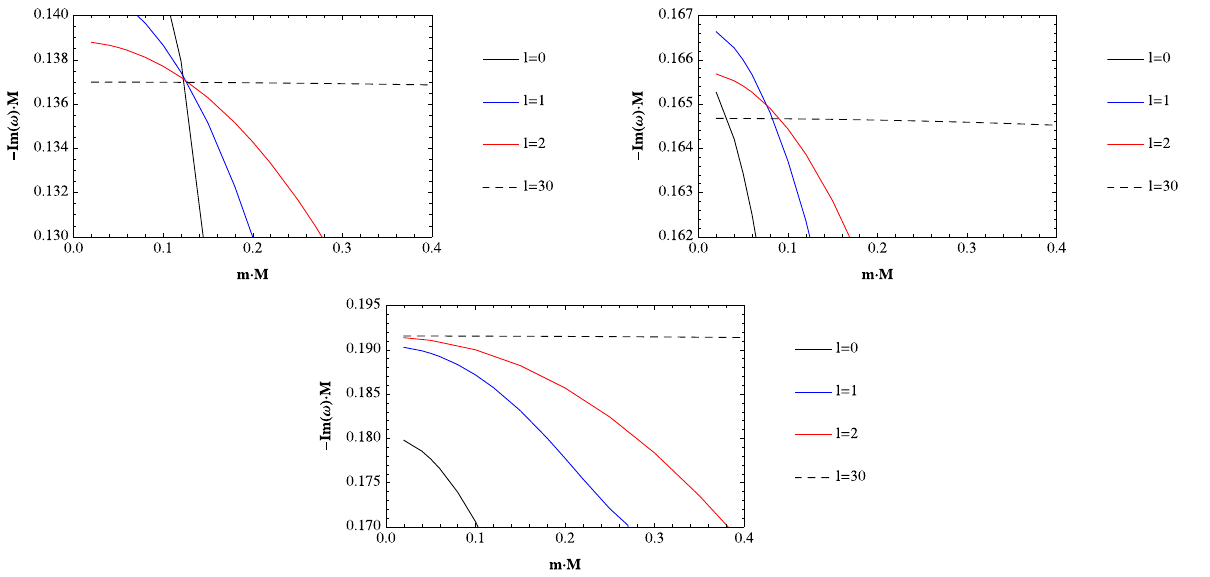
Fig. 5 The behavior of − Im (ω) M as a function of the scalar field mass mM for different values of the parameter (cid:5) = 0 , 1 , 2 , 30 and n PS = 0 with M 2 (cid:6) = 0 . 04, and M β = 0 . 1 (top panel), M β = 0 . 15 (center panel) and M β = 0 . 20 (bottom